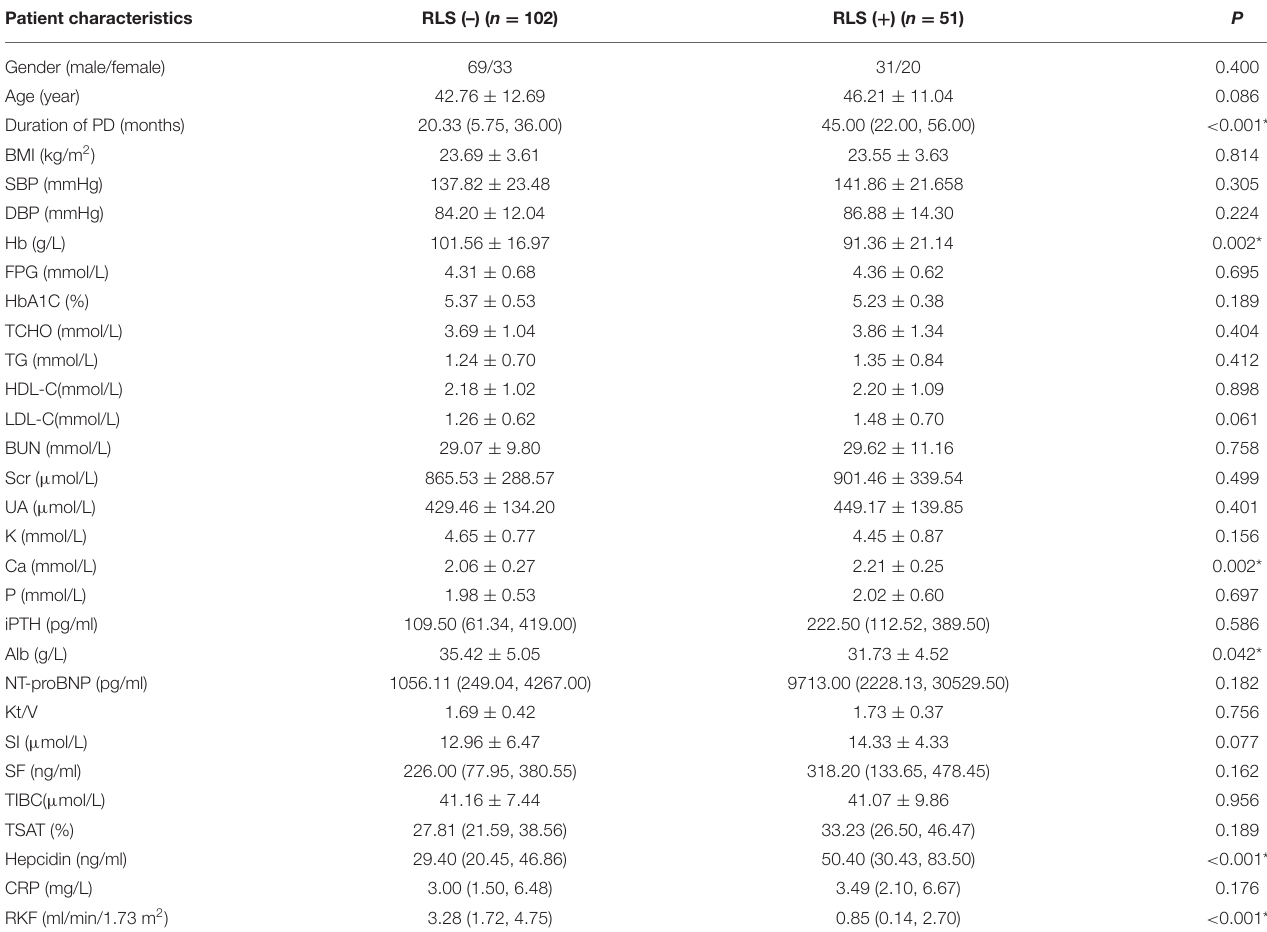
TABLE 1 | Demographic characteristics of patients undergoing PD. Patient